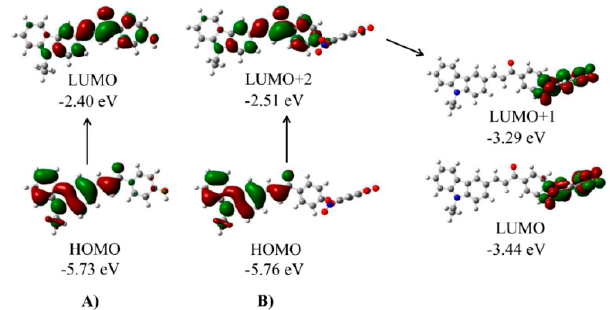
Figure 4. ( A ) Frontier molecular orbital plots of dye probe ‐ OH (CPCM model); ( B ) Frontier molecular orbital plots of probe ‐ KCP (CPCM model). The fluorescence emission of probe ‐ KCP moieties is quenched by d ‐ PET.